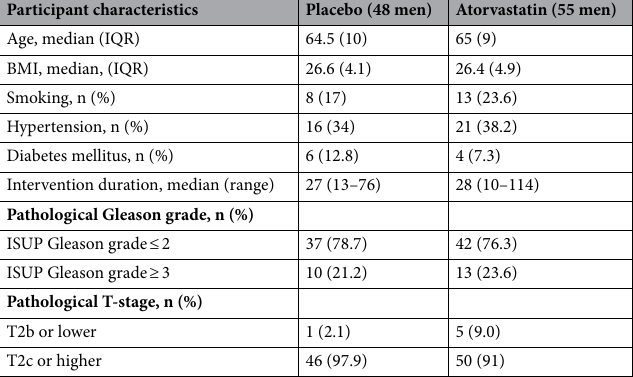
Table 1. Participant characteristic summary table per study arm. BMI Body Mass Index; IQR interquartile range, ISUP International Society of Urological